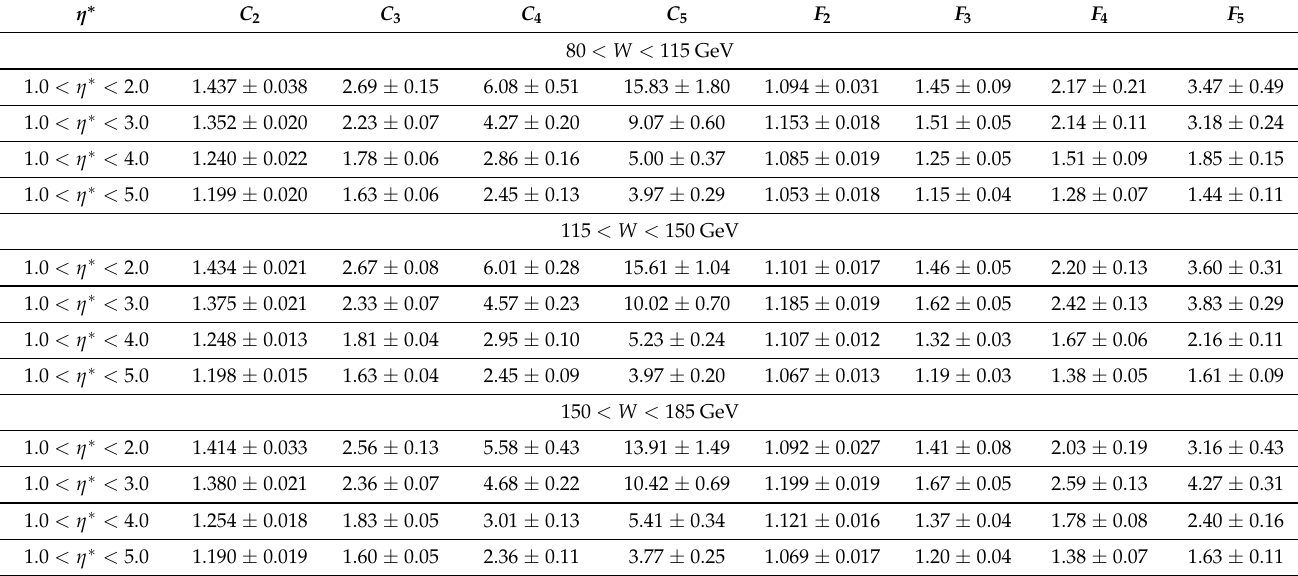
Table 4. Normalised moments and normalised factorial moments calculated from the WD fits to the data [33] for different W